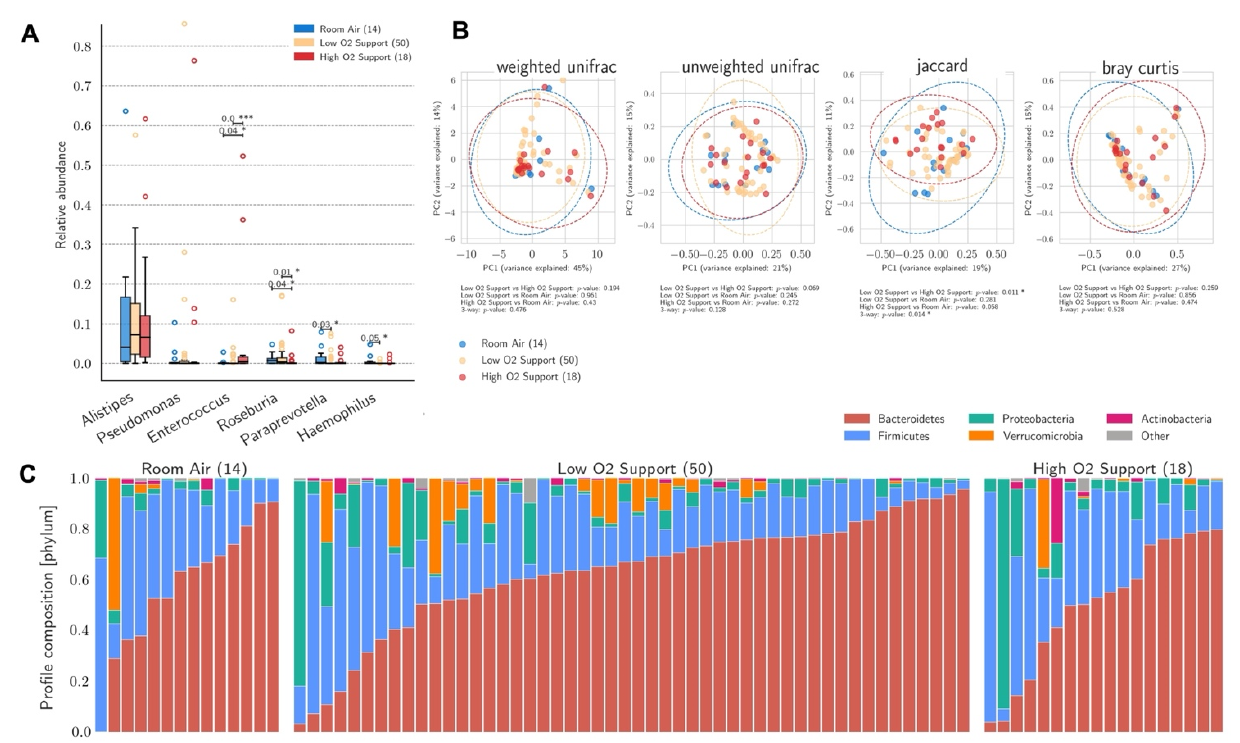
Figure 3. Microbiome profile composition, relative abundance, and bacterial beta diversity according to O 2 therapy. ( A ) Relative abundance analysis showed higher levels of Enterococcus and lower levels of Roseburia in patients receiving high compared to low O 2 support or no O 2 support (room air). Paraprevotella and Haemophilus were more abundant in patients with no O 2 support compared to those with low O 2 support. ( B ) PCoA plots of beta diversity between the three groups showed a significant difference in richness (Jaccard similarity index) between low and high O 2 support. ( C ) General profile composition of samples at phylum level in the three O 2 support groups. Statistical significance reported as * p ≤ 0.05, *** p ≤ 0.001.